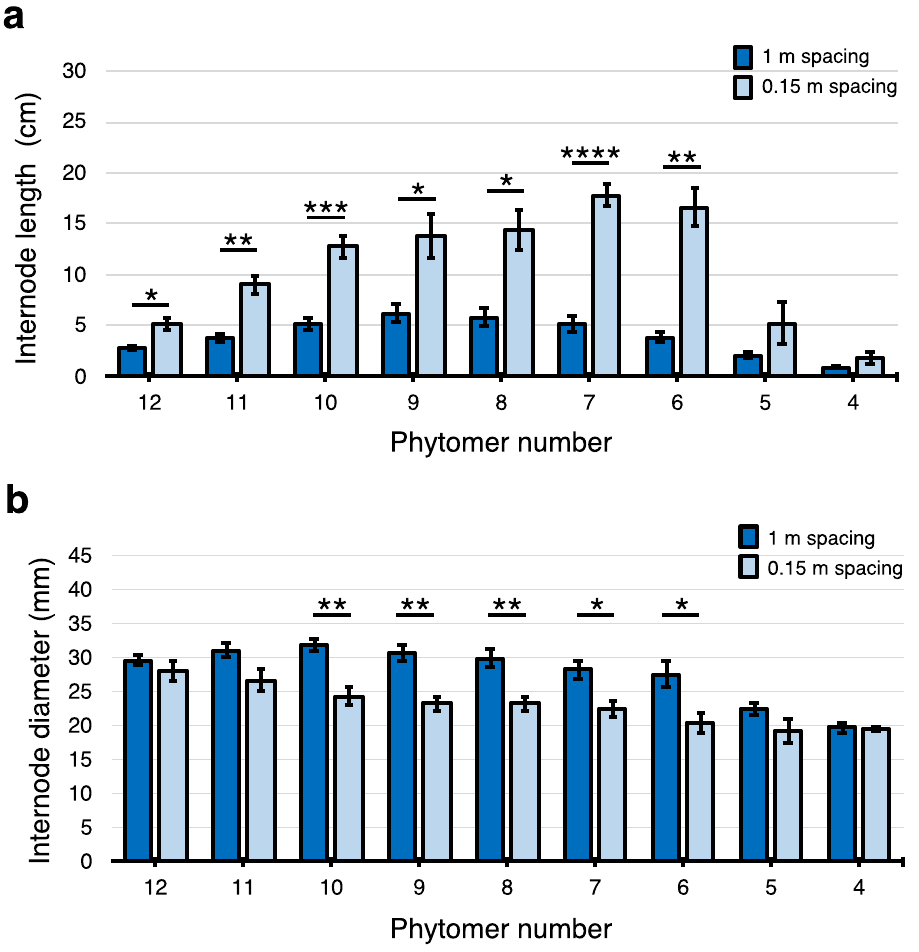
Figure 2. Plant spacing alters sorghum stem internode growth during development. Average internode lengths (cm) ( a ) and diameters (mm) ( b ) of 9 phytomers of bioenergy sorghum grown at 1 m and 0.15 m spacing for 60 days (DAE) in the field. Phytomer 12 is located at the base of the stem. Asterisks indicate two-tail Welch’s t test, ****P < 0.0001, ***P < 0.001, **P < 0.005, *P < 0.05, by one-way ANOVA (n = 5). Error bars: